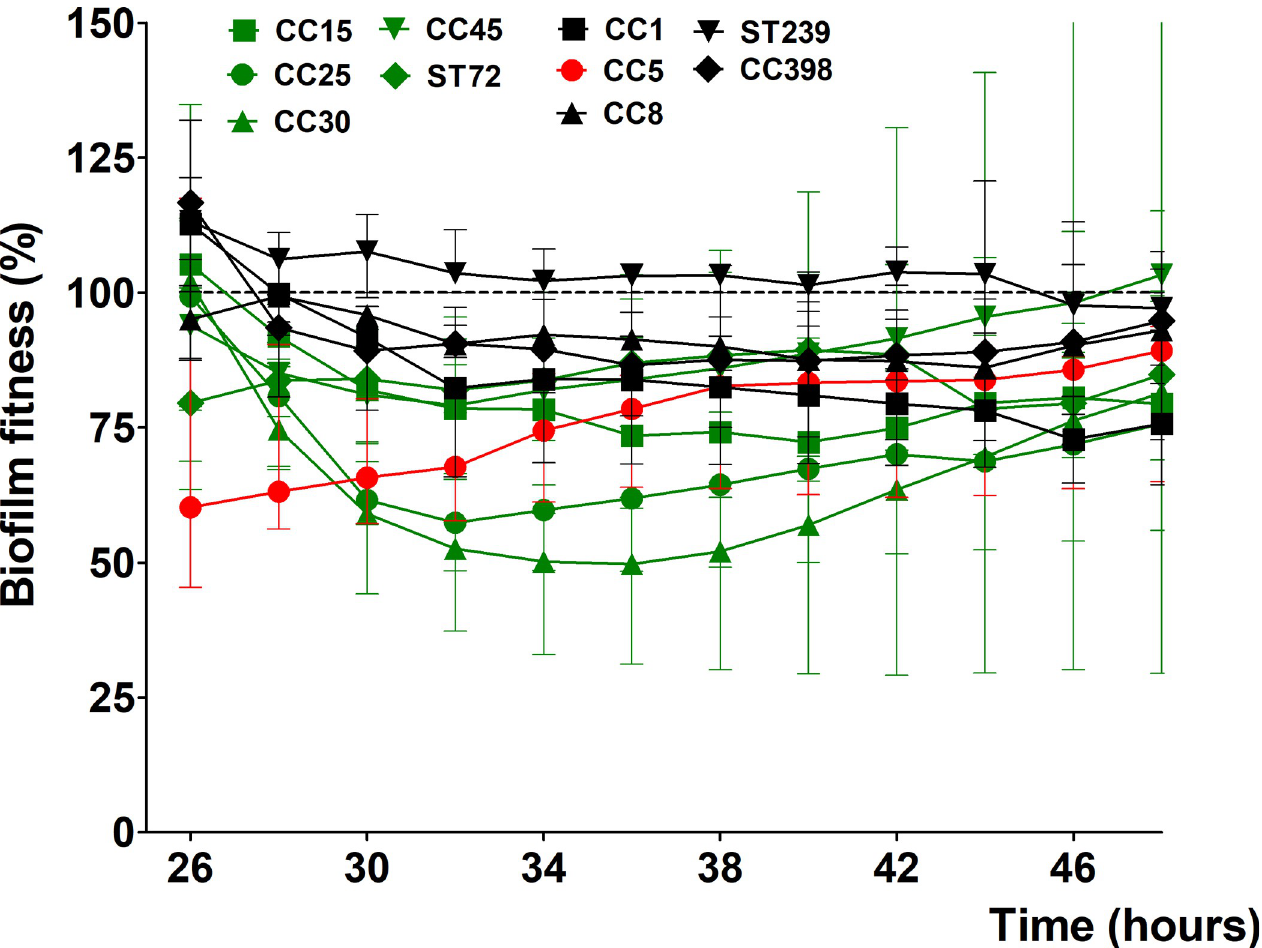
Fig 3. Biofilm-associated S . aureus sensitivity to flucloxacillin (FLX). The 24 hours kinetic of biofilm fitness of MSSA (CC15, CC25, CC30, CC45, and ST72) and MRSA (CC1, CC5, CC8, ST239, and CC398) strains towards 16 μ g/mL flucloxacillin relative to untreated biofilm fitness. Mu50 (CC5) is used as non- susceptible control (red). Dashed horizontal lines indicate control (untreated biofilm). Error bars represent median with range (n = 3).